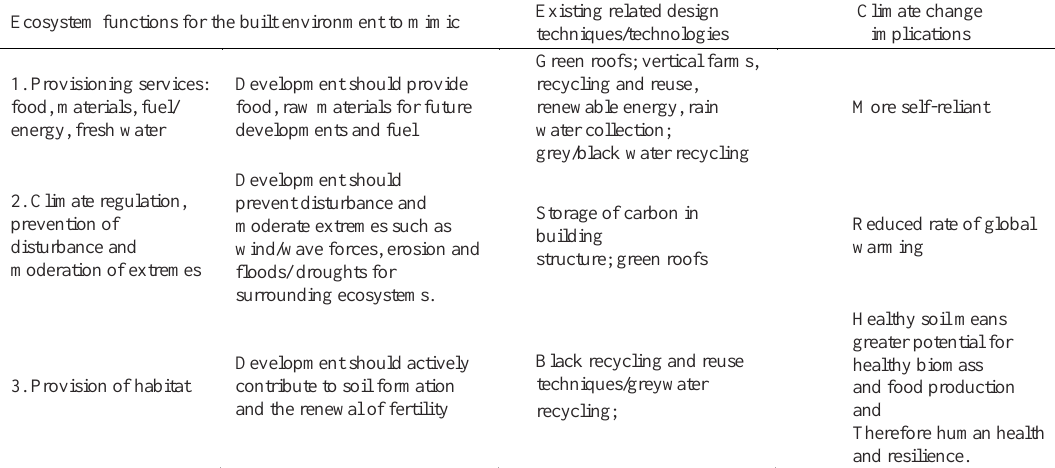
Ecosystem functions for the built environment to